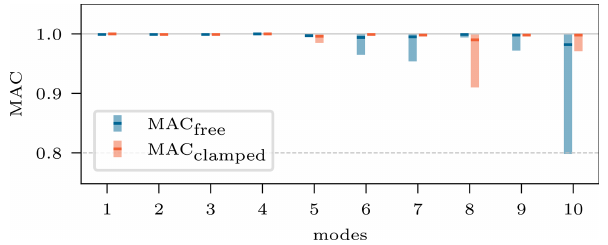
Figure 17. Mean, maximum, and minimum diagonal entries of the MAC matrices computed for 1000 target responses.